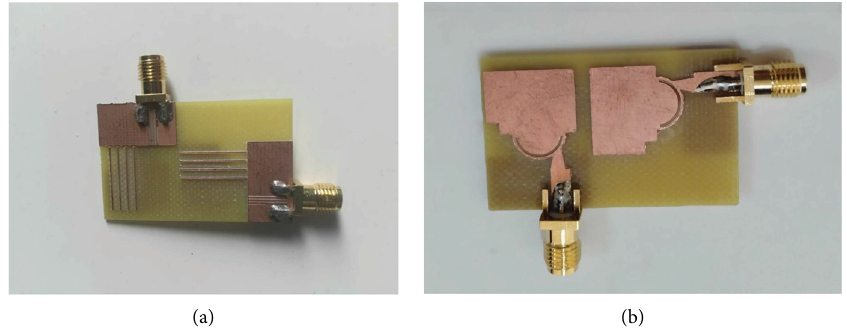
Figure 5: Prototype of UWB-MIMO crosses antenna. (a) Front view. (b) Back view and co and cross s